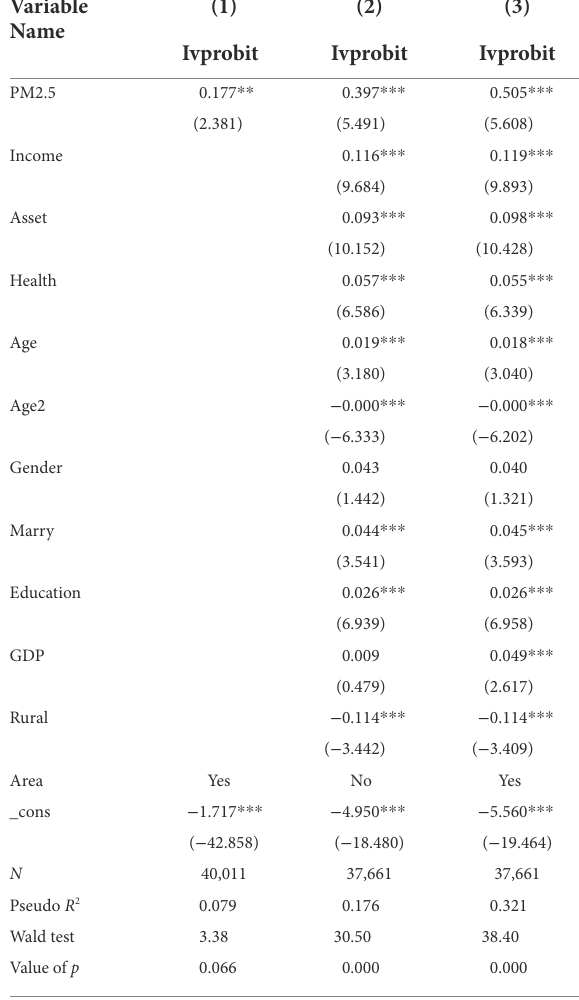
TABLE 2 Impact of haze pollution on demand for commercial health